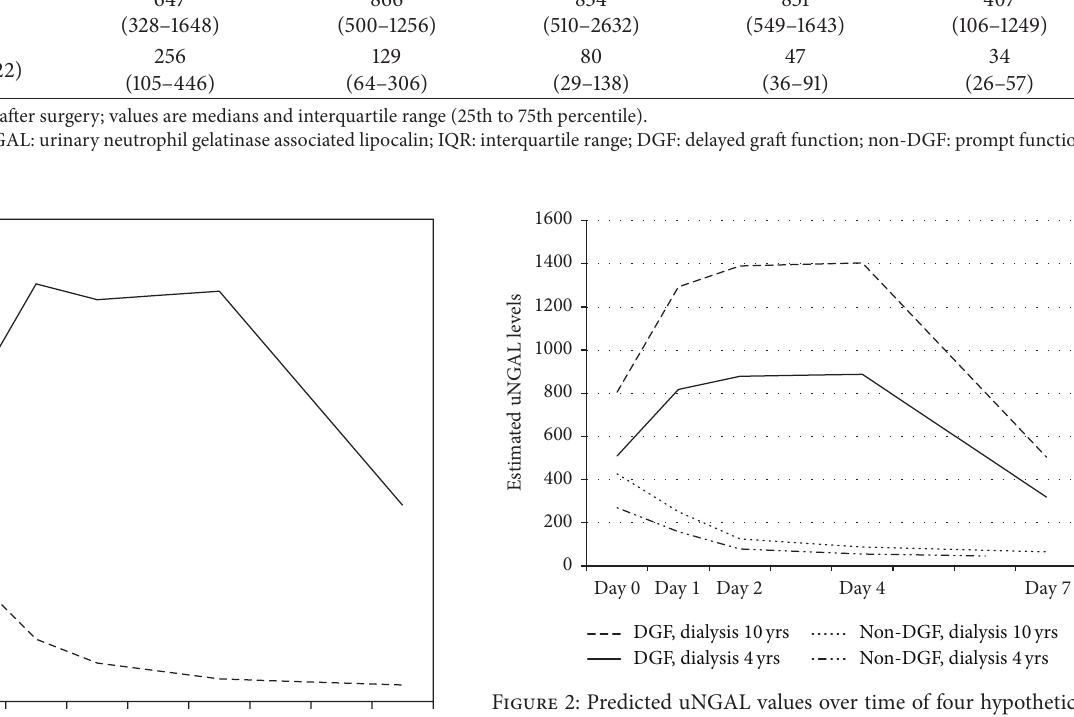
Figure 2: Predicted uNGAL values over time of four hypothetical subjects, estimated from multiple linear mixed model presented in Table 3. Abbreviations: uNGAL: urinary neutrophil gelatinase associatedlipocalin;DGF:delayedgraftfunction;non-DGF:prompt graft